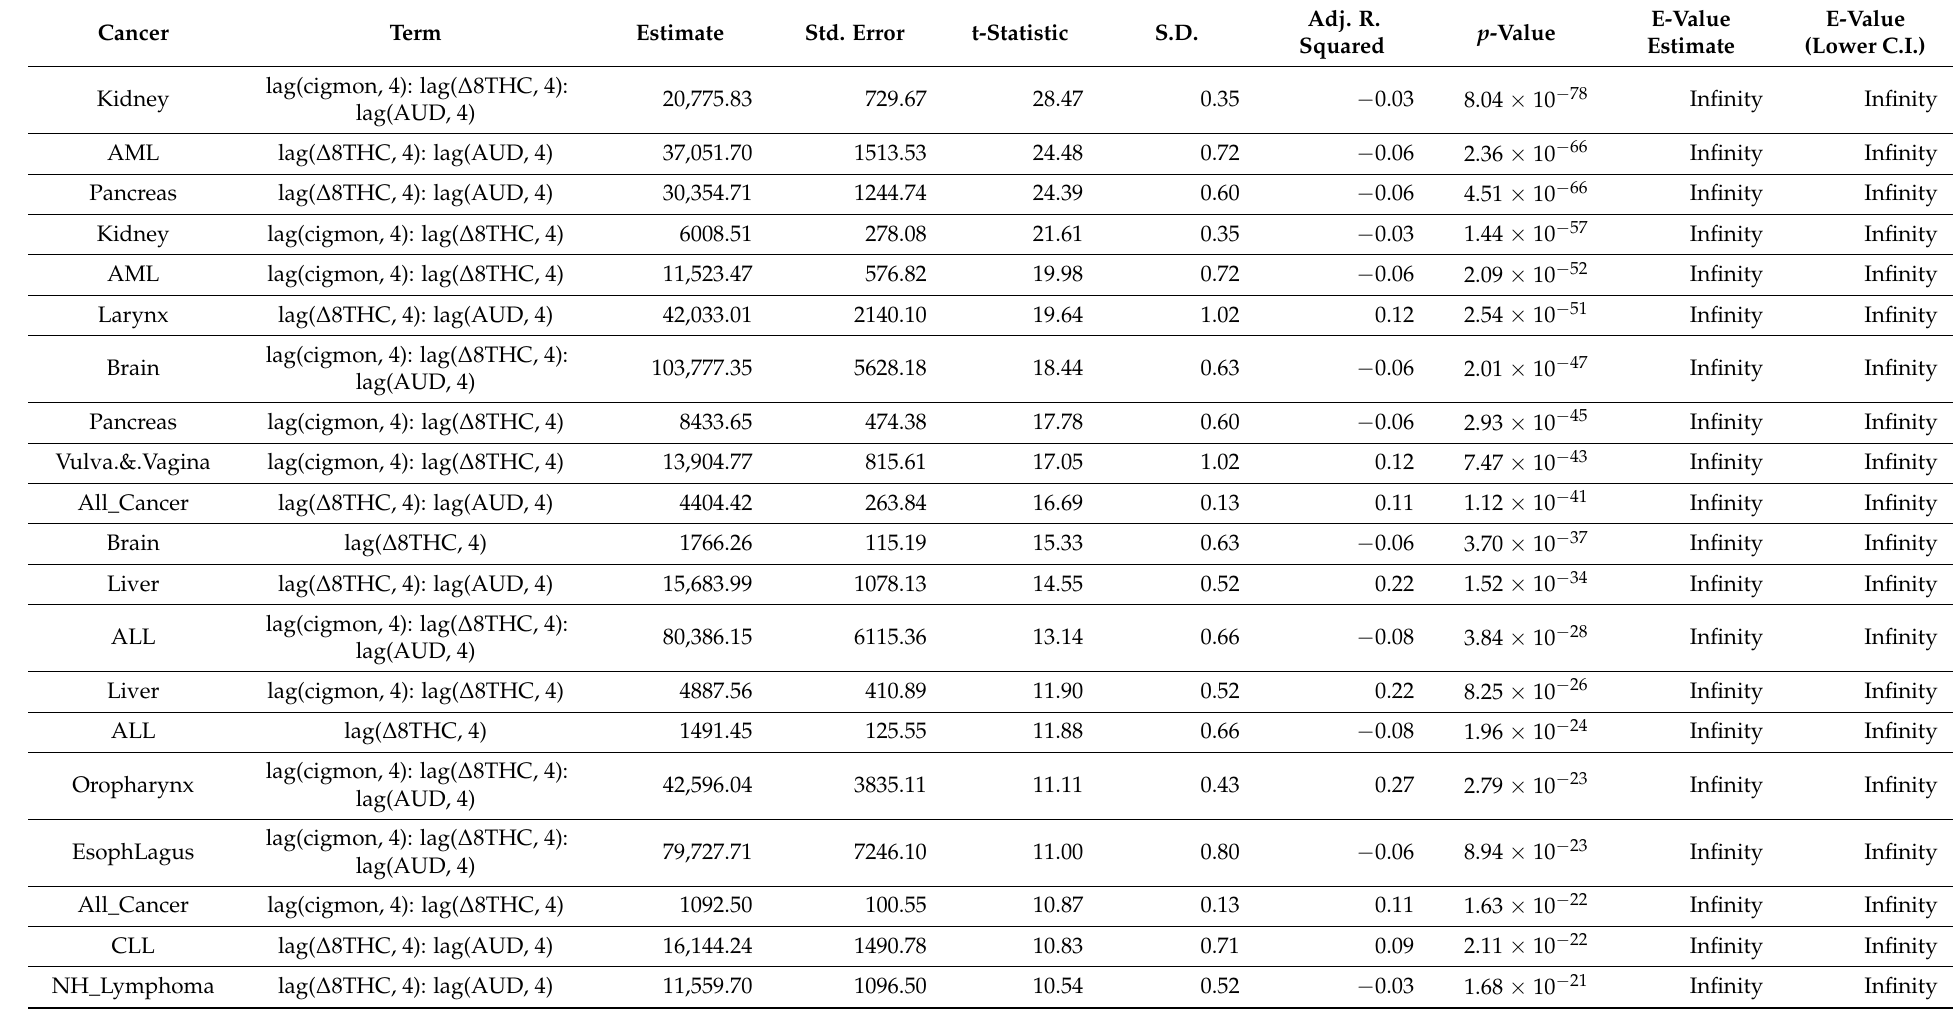
Table 4. Significant terms including ∆ 8THC from the interactive panel model at four years lag.